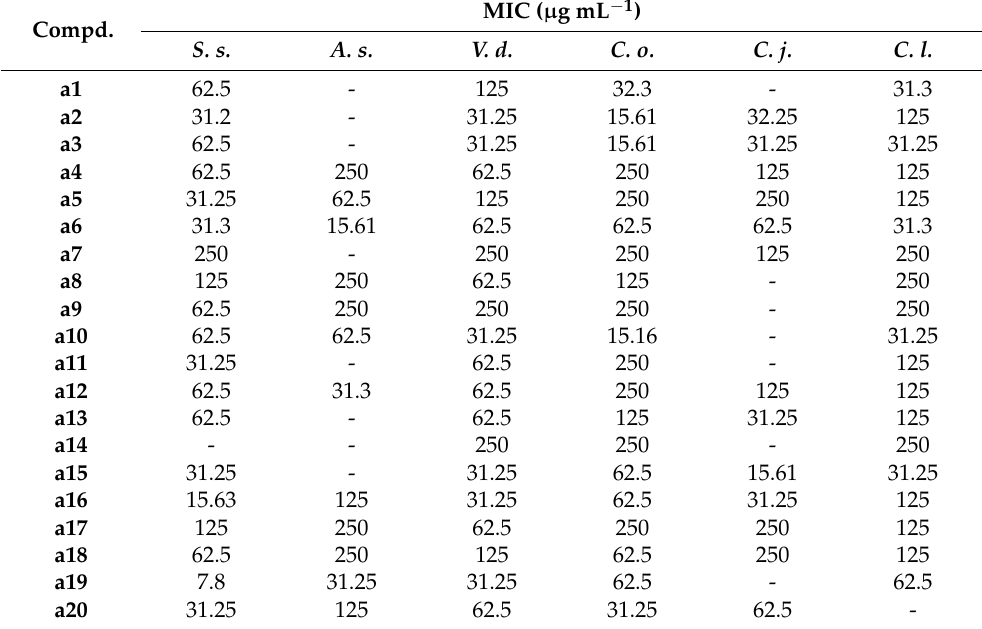
Table 1. MIC of Chimonanthus praecox derivatives against 6 plant pathogens.